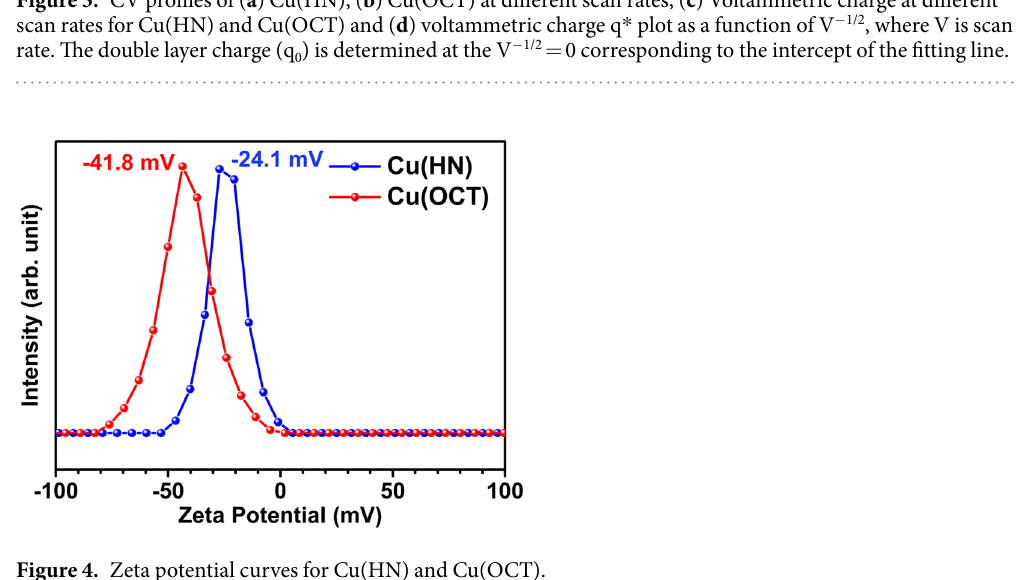
Figure 4. Zeta potential curves for Cu(HN) and